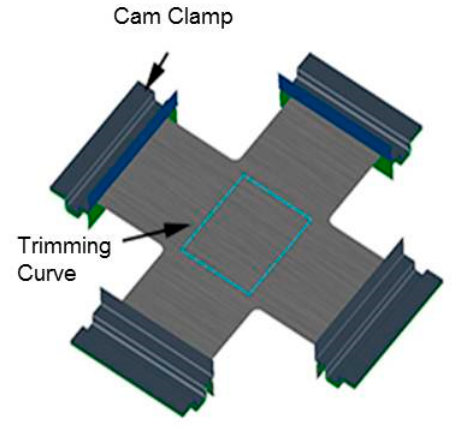
Figure 8. Geometric model of biaxial stretching and trimming.